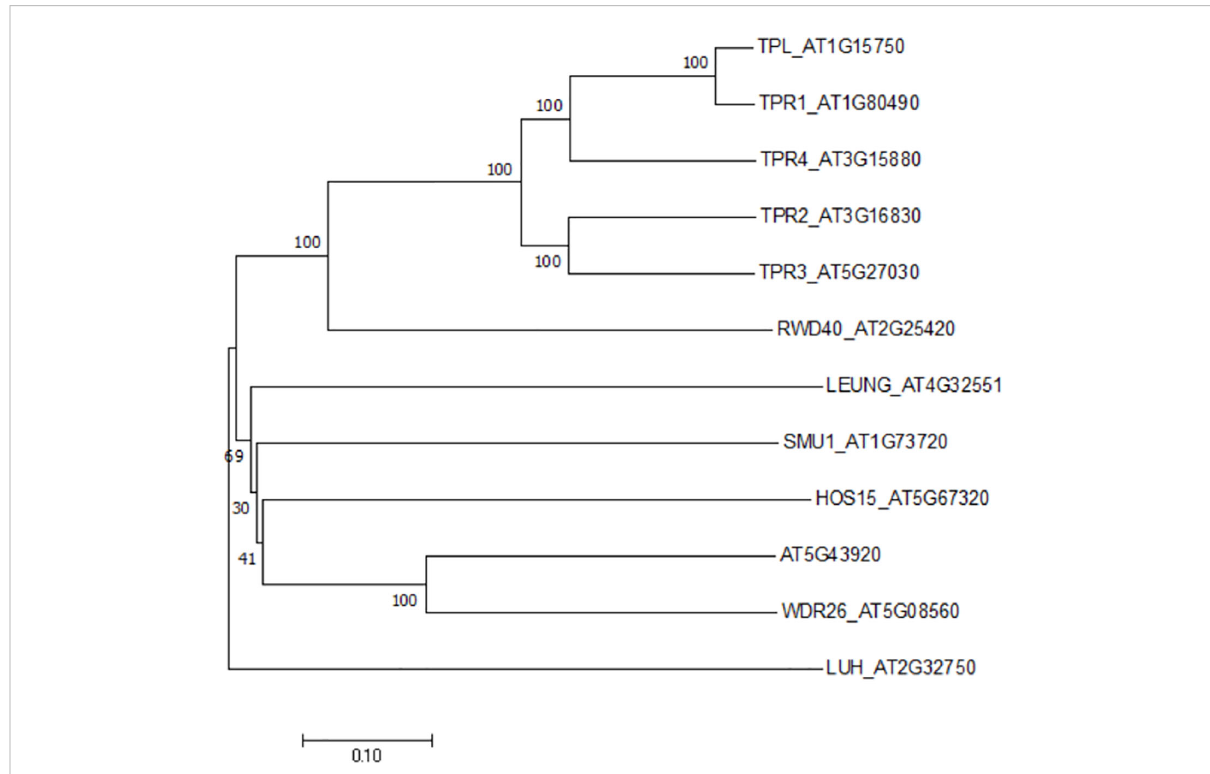
FIGURE 1 A phylogenetic tree of the Gro/Tup1 corepressor gene family in Arabidopsis. The gene names were followed by TAIR locus numbers. An unrooted neighbor- joining tree was generated by MEGA X with full-length sequences (1, 000 bootstrap